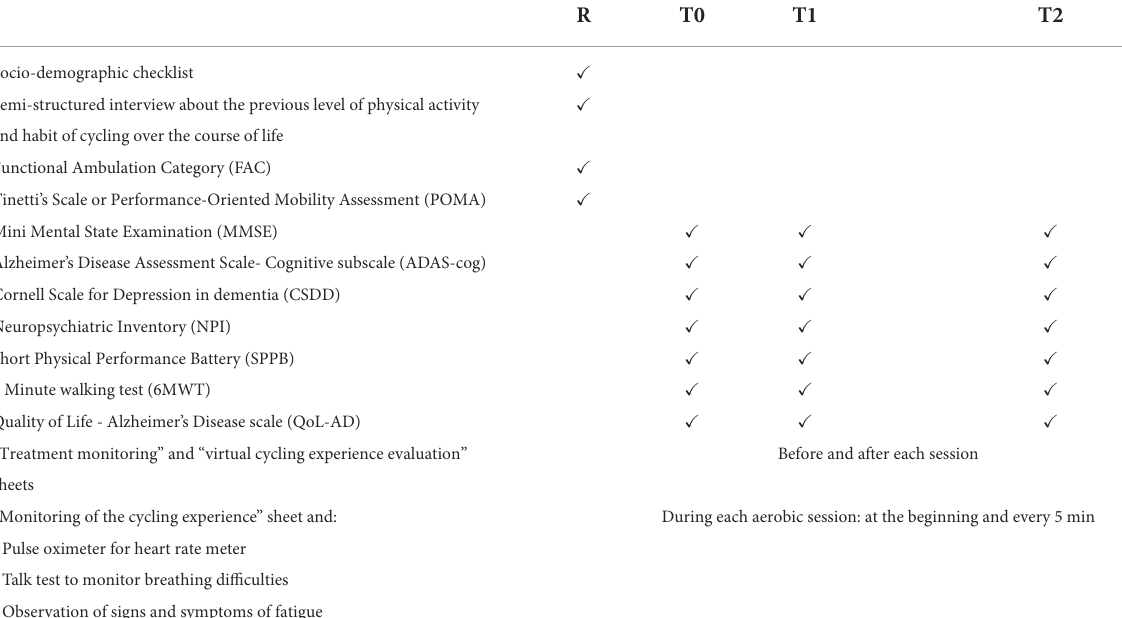
TABLE 3 Schedule of assessment and outcome